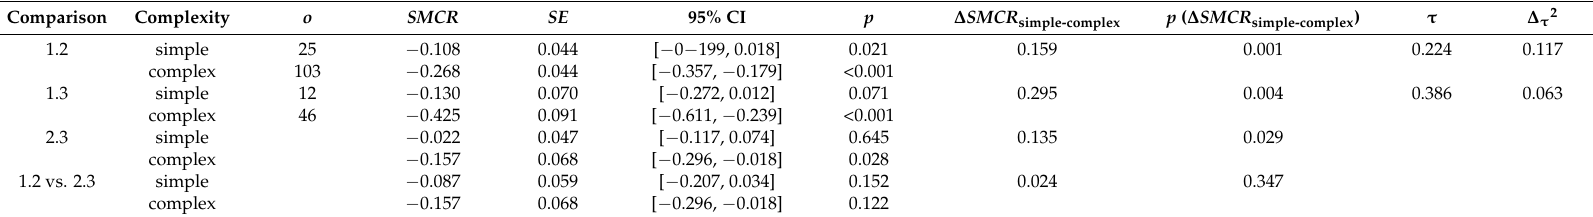
Table 4. Subgroup Analysis for Task